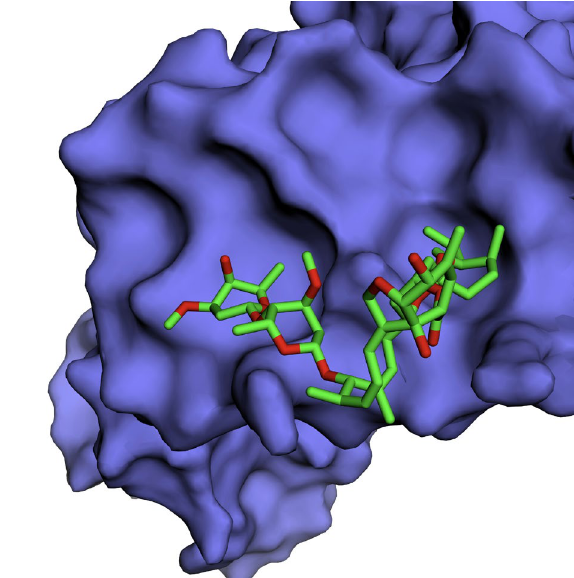
Figure 2. Ivermectin binding site on IAV NS1